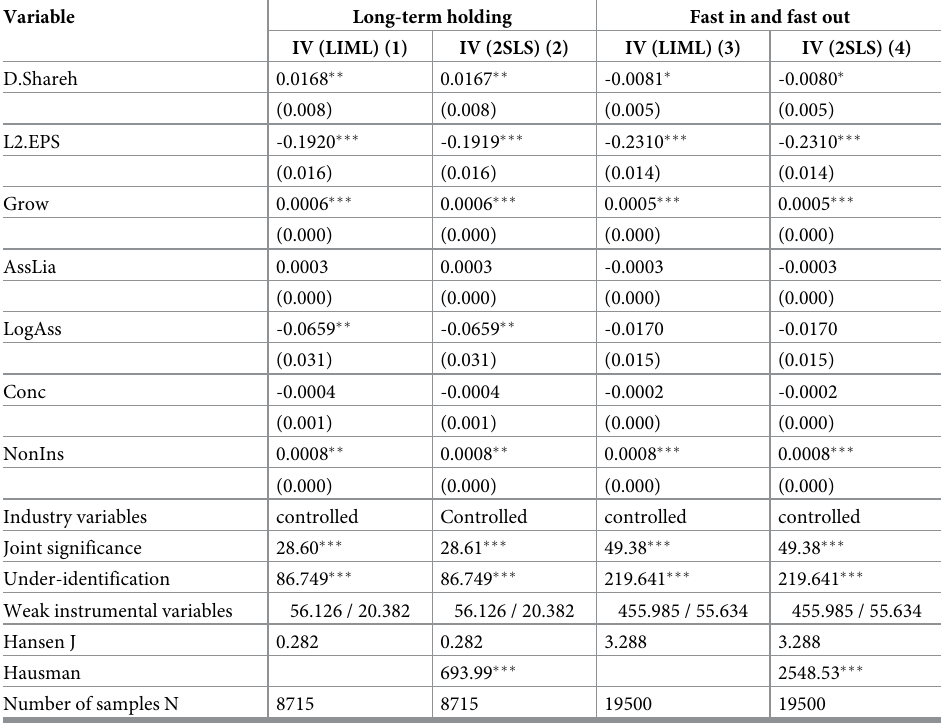
Table 5. Value creation model (the explained variable is the change in earnings per share, namely: D.EPS).